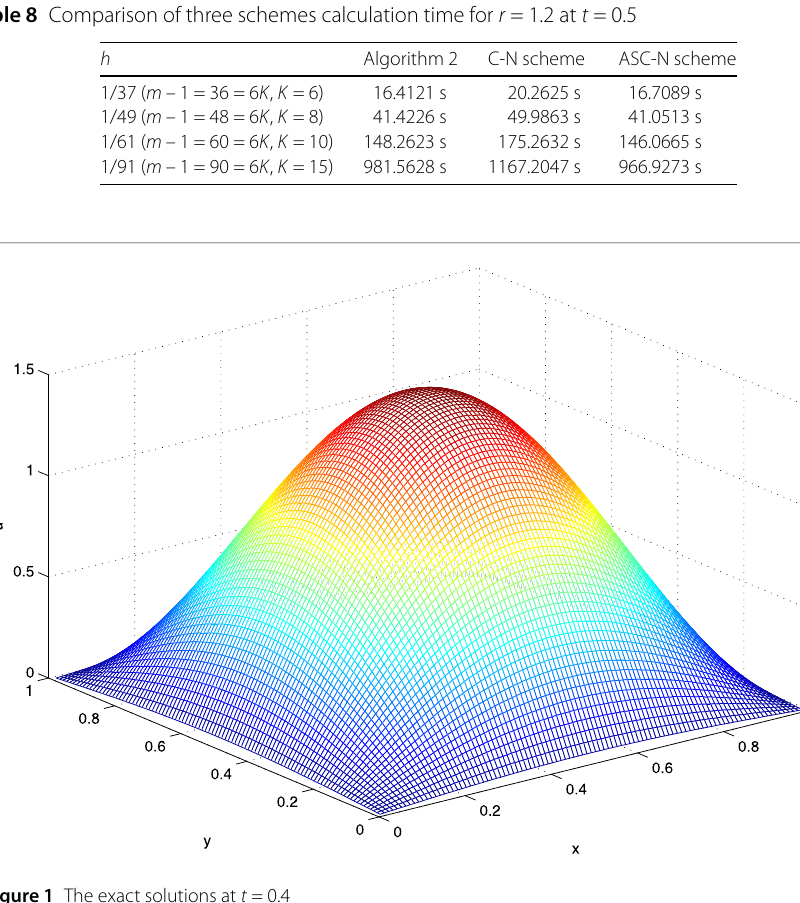
Figure 1 The exact solutions at t =